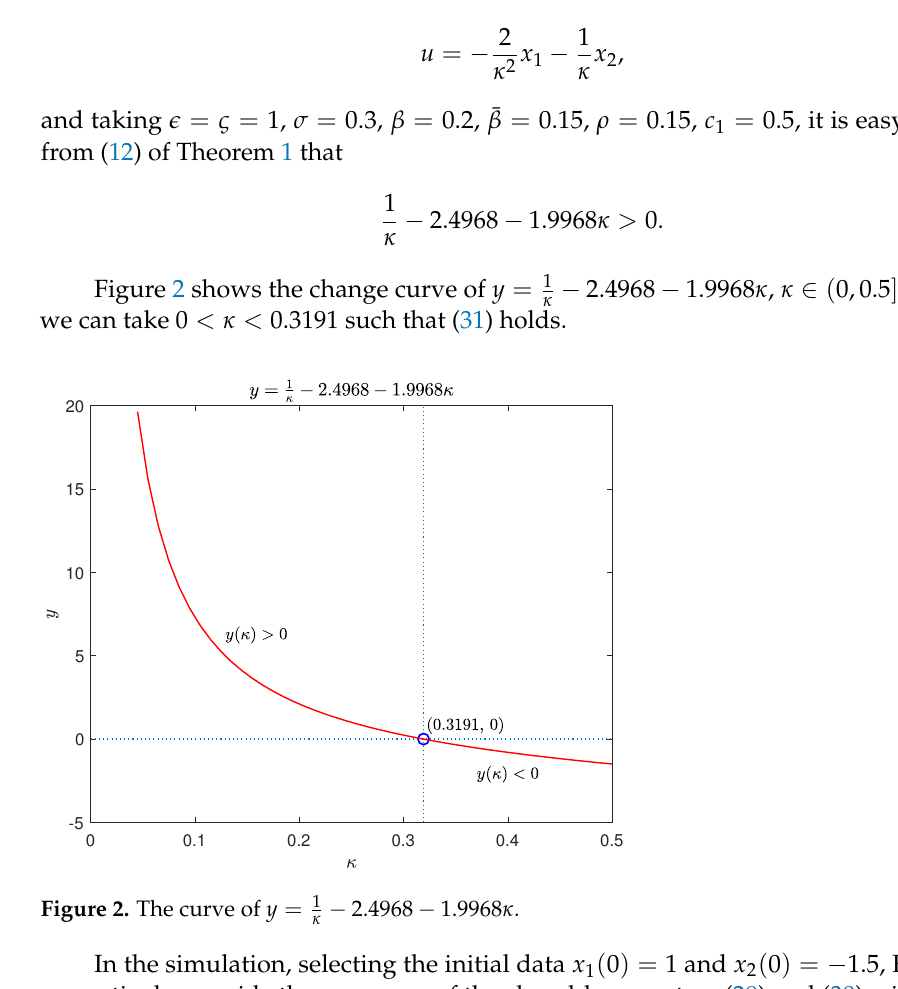
and taking (cid:101) = ς = 1, σ = 0.3, β = 0.2, ¯ β = 0.15, ρ = 0.15, c 1 = 0.5, it is easy to deduce from (12) of Theorem 1 that